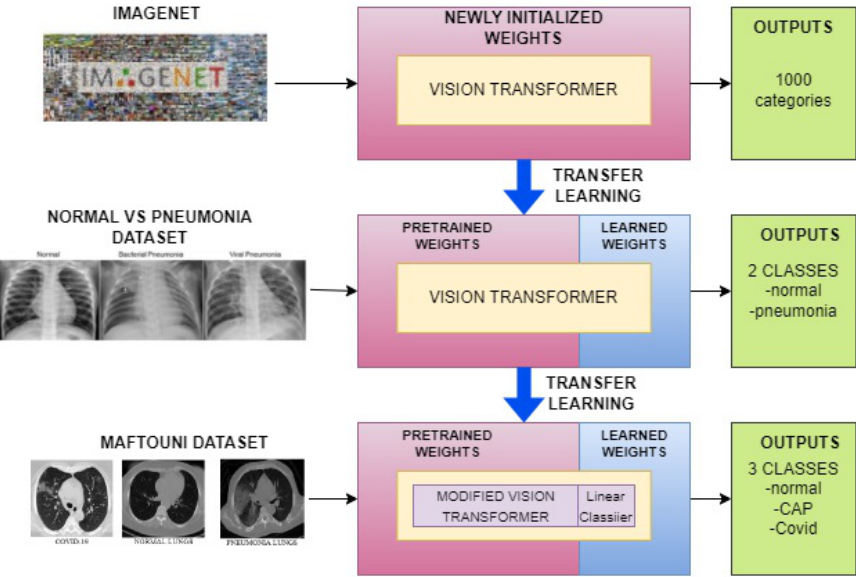
Figure 4. Two-step Transfer Learning approach.